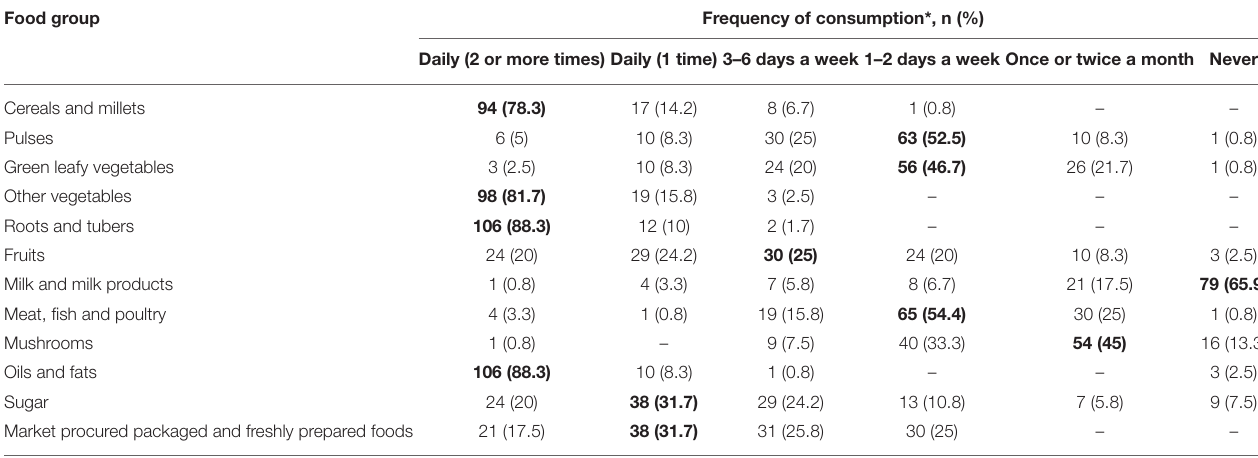
TABLE 3 | Frequency of food group consumption at household level ( n = 120) during monsoon season, in Sauria Paharia community of Jharkhand, India. Food group